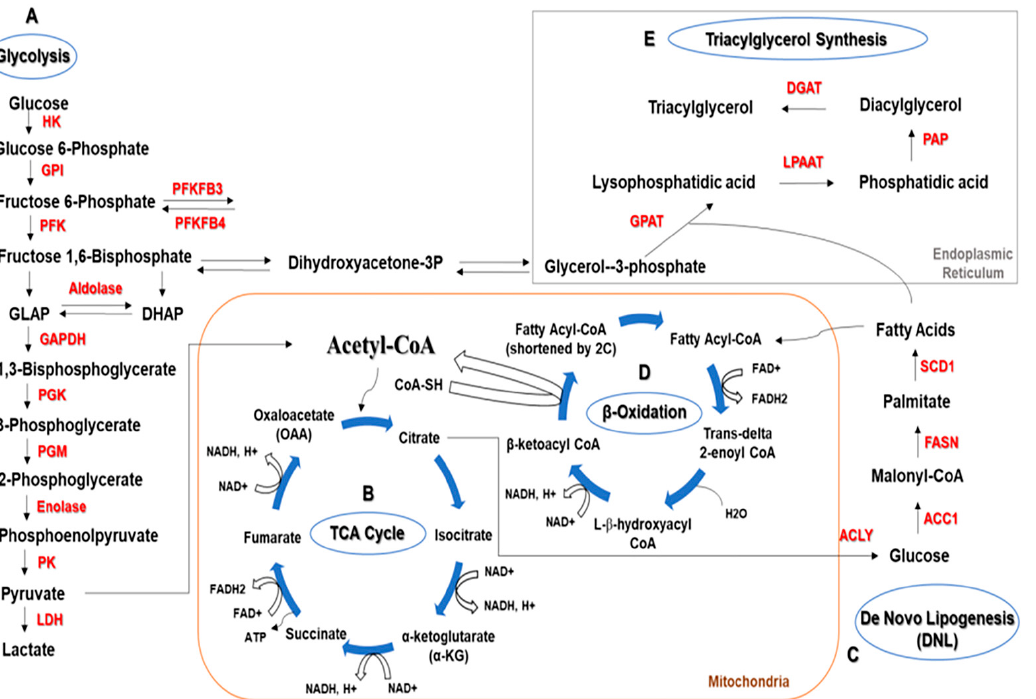
Figure 2. ( A ) Glycolysis : This includes 10 consecutive enzymatic reactions in the conversion of glucose into two molecules of pyruvate, which connect with other metabolic pathways. Glucose is phosphorylated to glucose 6-phosphate by the enzyme hexokinase (HK). Glucose 6-phosphate is turned into fructose 6-phosphate by glucose phosphate isomerase (GPI). Phosphofructokinase-1 (PFK) catalyzes the conversion of fructose 6-phosphate and ATP to fructose 1,6-bisphosphate and ADP. 6-phosphofructo2-kinase/fructose 2,6-bisphosphatase (PFKFB), a family of bifunctional enzymes that control the levels of fructose 2,6-bisphosphate (PFKFB3 and PFKFB4 are the two main isoenzymes of this family) (PFK and PFKFB are the two major regulatory enzymes in glycolysis). Subsequently, the aldolase enzyme catalyzes a reversible reaction in which fructose 1,6-bisphosphate converts into glyceraldehyde-3-phosphate (GLAP) and dihydroxyacetone phosphate (DHAP). Glyceraldehyde-3-phosphate dehydrogenase (GAPDH) produces 1,3-bisphosphoglycerate. Next, phosphoglycerate kinase (PGK) forms ATP and 3-phosphoglycerate. Phosphoglycerate mutase (PGM) isomerizes 3-phosphoglycerate into 2-phosphoglycerate. Next, enolase converts 2-phosphoglycerate to phosphoenolpyruvate, which is phosphorylated to form a molecule of pyruvate and a molecule of ATP via pyruvate kinase (PK). Finally, lactate dehydrogenase (LDH) catalyzes the conversion of pyruvate to lactate. ( B ) Krebs cycle : The TCA cycle starts with the combination of acetyl-CoA, generated from fatty acids, amino acids, or pyruvate oxidation, with oxaloacetate (OAA) to produce citrate. Citrate is converted into isocitrate. The cycle continues with two consecutive oxidative decarboxylations in which isocitrate is converted into the α -ketoglutarate ( α -KG) and the succinyl-CoA concomitantly, producing two CO 2 and two NADH. Succinyl-CoA coverts into succinate, coupled with the release of ATP. Subsequently, fumarate is formed by the oxidation of succinate. During this step, two hydrogen atoms are transferred to FAD, producing 2FADH. Next, fumarate is converted into malate and further into OAA, which combines with another acetyl-CoA, continuing the cycle [51]. ( C ) De novo lipogenesis C : In this simplified scheme, pyruvate from glycolysis feeds acetyl-CoA to the TCA cycle. Citrate from the TCA cycle is converted to acetyl-CoA in the cytosol by ATP citrate lyase (ACLY). Acetyl-CoA from the TCA cycle and other sources is subsequently converted to complicated fatty acids by a series of enzymes including ATP-citrate lyase (ACLY), acetyl-CoA carboxylases 1 (ACC1), fatty acid synthase (FASN), and stearoyl- CoA desaturase-1 (SCD1). ( D ) Fatty acid β -oxidation: Each cycle leads to the formation of acetyl- CoA, nicotinamide adenine dinucleotide (NADH), and flavin adenine dinucleotide (FADH 2). The electron carriers NADH and FADH2 are used by the mitochondrial respiratory chain to generate ATP. ( E ) Triacylglycerol synthesis: This reaction occurs at the surface of the endoplasmic reticulum (ER) bilayer membrane. The first step in this pathway is the acylation of glycerol-3-phosphate by glycerol-3-phosphate acyltransferase (GPAT), producing lysophosphatidic acid. This is followed by further acylation by LPA acyltransferase (LPAAT) and dephosphorylation by phosphatidic acid phosphorylase (PAP) to yield diacylglycerol (DAG). The final step is converting 1,2-diacylglycerol into triacylglycerol (TAG), which is catalyzed by diacylglycerol acyltransferase (DGAT).